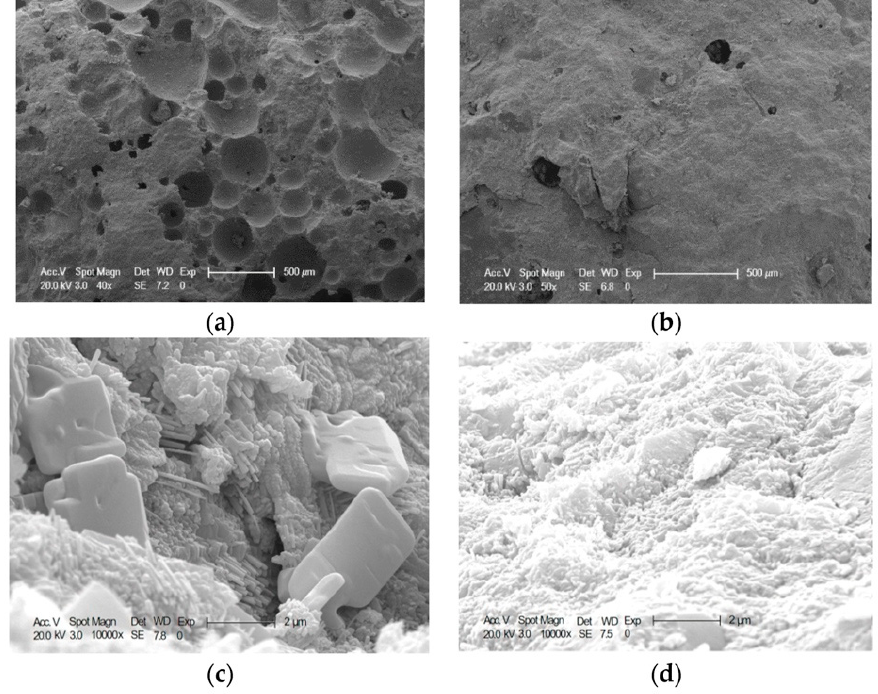
Figure 9. ( a , c ) 40 × , 10,000 × ordinary concrete (28 days curing) and ( b , d ) 50 × , 10,000 × 10% CANCP concrete (28 days curing) SEM micrographs.